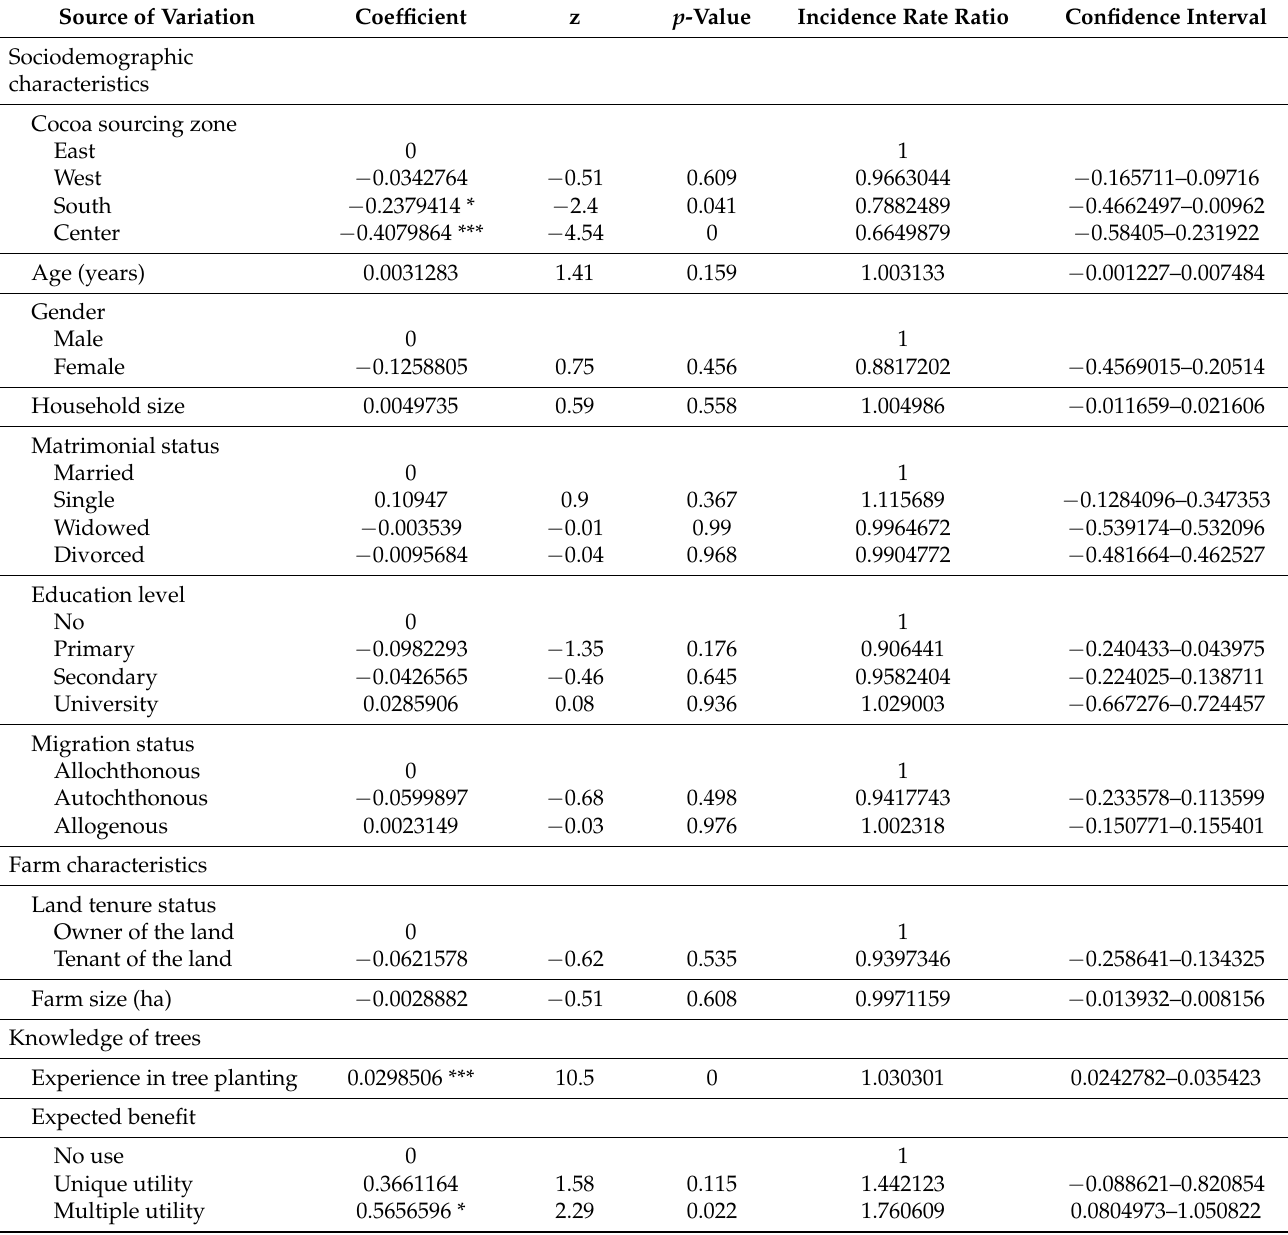
Table 3. Generalized Poisson regression model estimates of the factors driving retention of tree species when clearing land for cocoa farming in C ô te